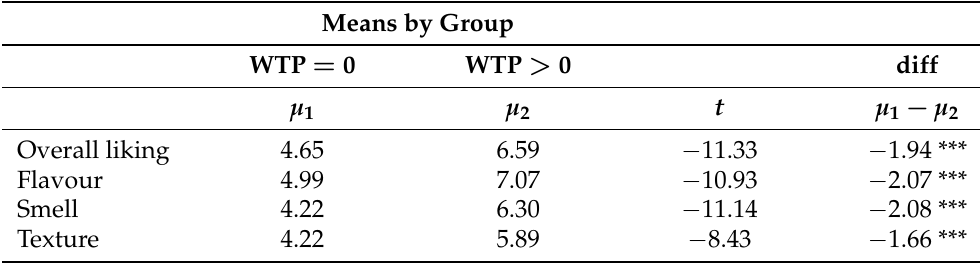
Table 4. Two-sample T-test with unequal variances: differences in mean hedonic scores between groups (group 1—161 respondents: WTP = 0; group 2—88 respondents: WTP > 0). Means by